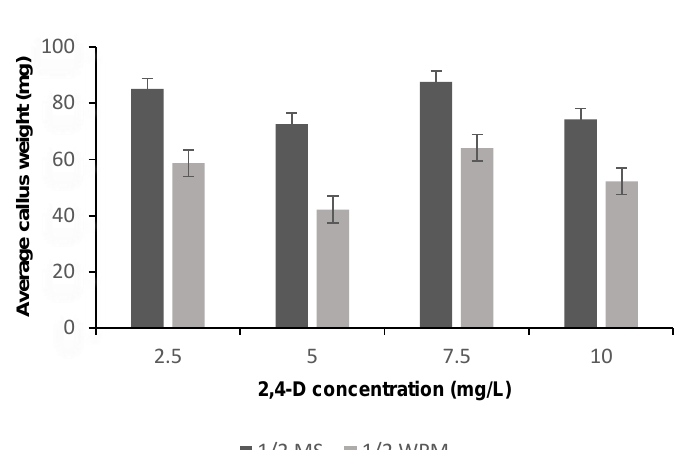
Figure 3. The means of the somatic embryogenesis percentage on different media supplemented with different 2,4-D concentrations after 6 weeks of subculture. Somatic embryogenesis is one of the pathways for in vitro plant regeneration. The relationship between culture medium composition and explant type leads to somatic embryo formation, but this relationship is complex and remains poorly understood. Most researchers use the classical approach of manipulating the ratios of plant growth regulators to optimize the quality and the number of embryos. In spite of this, several species and varieties do not respond to this classical approach and need additional optimization through the manipulation of other chemicals or physical factors [27]. A complete understanding of the factors that regulate induction, maturation, and germination of SEs will increase the efficiency of protocols for C. papaya propagation. Callus induction in C. papaya is frequently accomplished by adding 2,4-D to MS or ½ MS medium [11,28–30]. In general, small consideration has been offered to the constituents of media used for C. papaya propagation by somatic embryogenesis. In our study, two different types of media were tested in combination with several concentrations of 2,4-D to induce embryogenic callus formation. The types of media differed in their nitrogen level, total ionic strength, ammonium-to-nitrate ratio, and ammonium concentration. It may be inferred that one of these nutritional parameters could be responsible for the differences in embryogenic response. The best 2,4-D concentration for induction of somatic embryogenesis in ½ MS medium was 7.5 mg L −1 , but the differences among treatment levels were not statistically significant. Our results